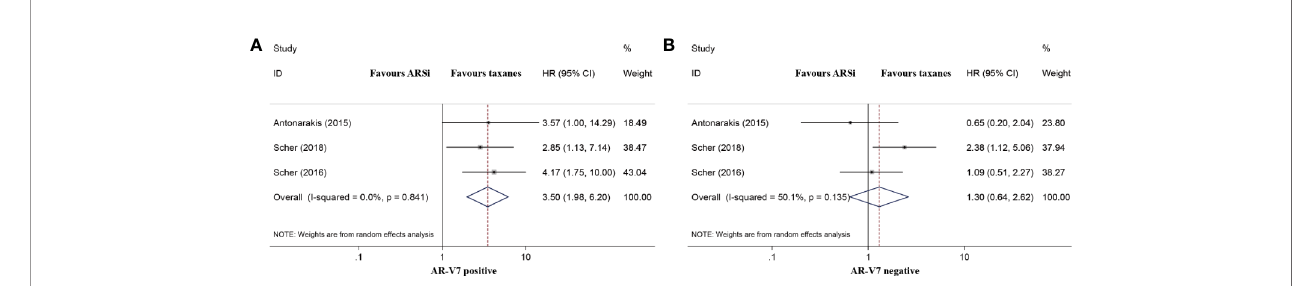
FIGURE 4 | Forest plot of overall survival (OS) of mCRPC patients treated with androgen receptor signaling inhibitiors (ARSi) or chemotherapy. (A) For AR-V7 positive patients, those receiving ARSi had a shorter median OS than those receiving chemotherapy; (B) For AR-V7 negative patients, there was no signi fi cant difference for the median OS between mCRPC patients treated with ARSi and chemotherapy. ARSi, androgen receptor signaling inhibitors; HR, hazard ratio; CI, con fi dence interval; AR-V7, androgen receptor splice